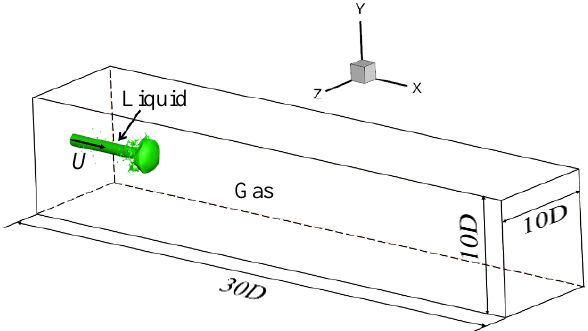
Table 1. Gas and liquid flow conditions.